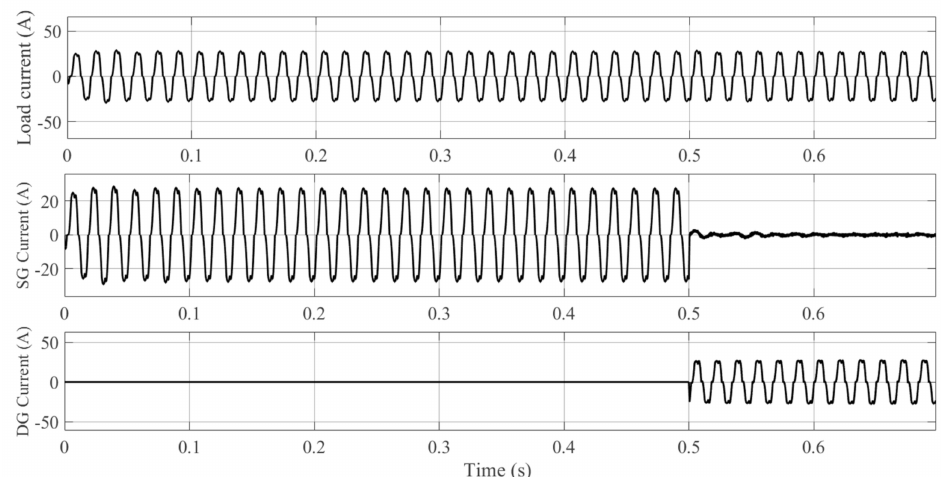
Figure 16. Load, synchronous generators (SG), and distributed generations (DG) currents before and after connecting the DG.